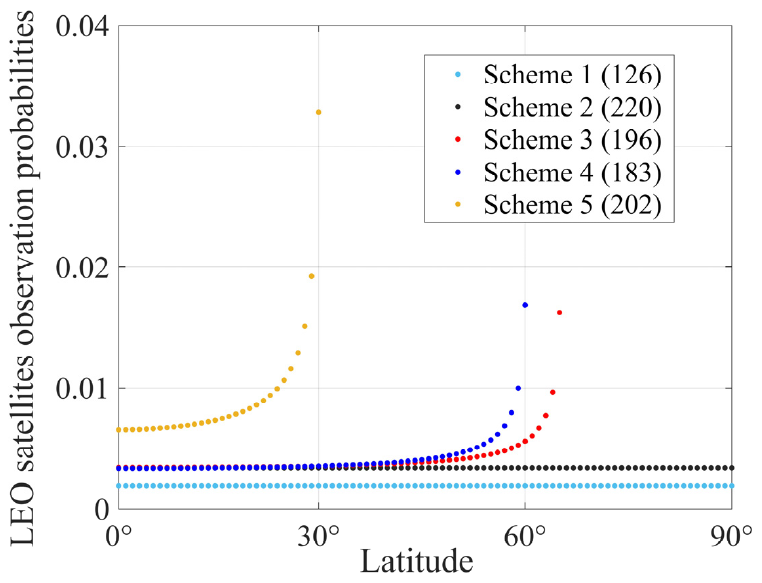
Figure 8. Distribution of Scheme 1–5 LEO constellation satellite observation probabilities. The coverage of the five Schemes LEO constellations is shown in Figure 9. Obviously, for Schemes 1 and 2, the satellite visibility varies greatly with increasing latitude, from approximately 4 LEO satellites at low latitudes to more than 16 at high latitudes. Scheme 3 is the most abundant in terms of visible satellites in the middle latitude region, with the number of visible satellites being over 10; however, that value significantly decreases in high-altitude regions. With a lower orbit inclination, the number visible satellites for Scheme 5 LEO constellation are larger in the low-latitude regions (30 ◦ S–30 ◦ N), where more than 12 satellites are visible.